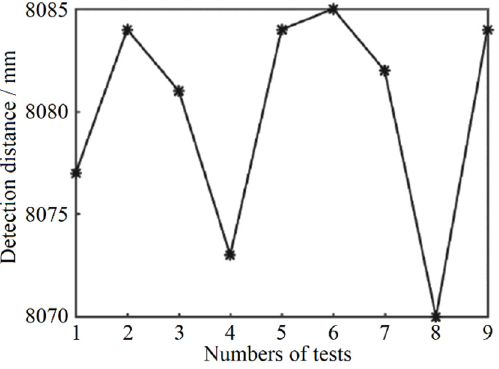
Figure 10. The achievable longest ranging distance. (* is the actual distance measurement result of the designed laser rangefinder.)